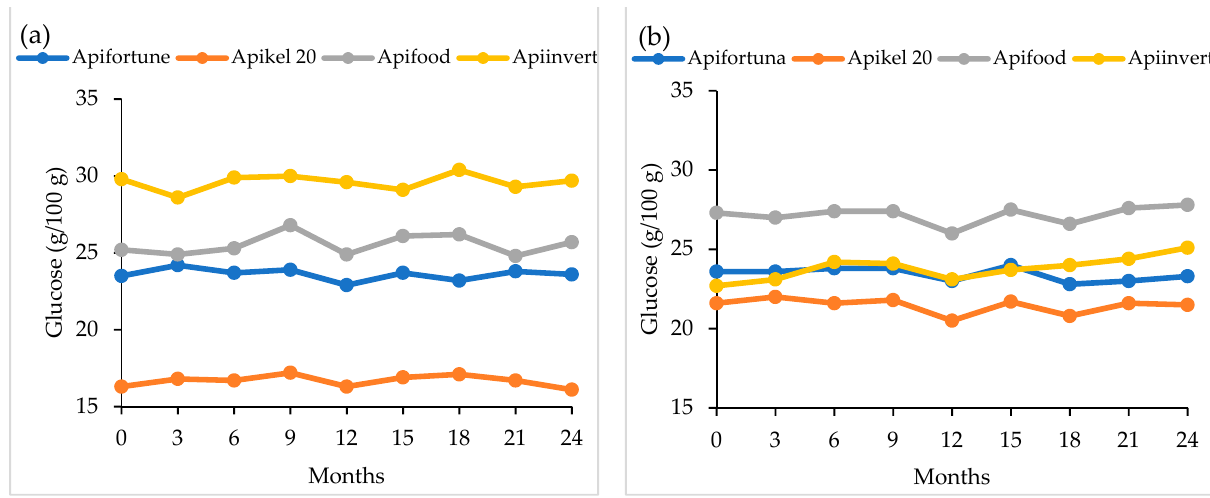
Figure 9. Changes of glucose content in syrups during storage at about 4 °C ( a ) from 2012 and ( b ) from 2013. No changes in the ratio of fructose to glucose content in starch syrups and inverted saccharose syrup during storage were found. The values of this parameter for stored syr- ups were on the same level as fresh syrups (Table 1). Saccharose content in inverted sac- charose syrup decreased during storage at different temperatures, and the highest de- crease of this disaccharide occurred at ca. 20 °C (Figure 10). At this temperature, saccha- rose content decreased by 70% (after 12 months) and 88% (after 24 months) in the syrup purchased in 2012 and 26% (after 12 months) and 60% (after 24 months) in the syrup from 2013. At lower temperatures (10–14 °C and ca. 4 °C), the saccharose breakdown to simple sugars was much slower. Figure 10. Changes of saccharose content in inverted saccharose syrup (Apiinvert) during storage ( a ) from 2012 and ( b ) from 2013. In starch syrups, small differences in the contents of maltose and maltotriose between fresh and stored syrups were found (Figures 11–16), whereas no differences in the con- tents of maltodextrins between fresh and stored starch syrups were noticed. Even after 24 months of storage at all the tested temperatures (ca. 20 °C, 10–14 °C, and ca. 4 °C), the maltodextrins content in starch syrups was at the same level as fresh syrups (Table 1).